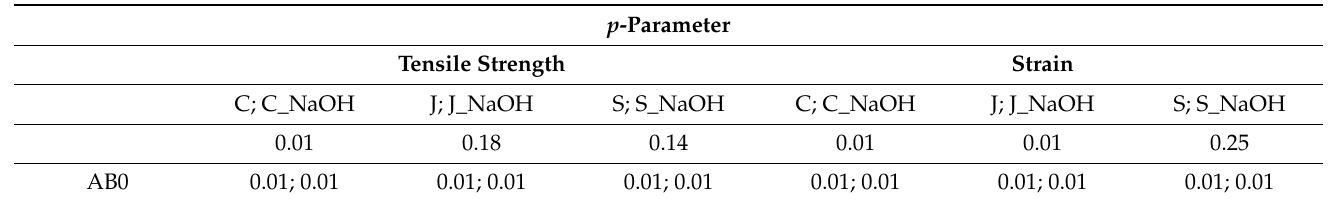
Table 4. Statistical evaluation of static tensile test at 0.05 level of significance-ANOVA F-test. p -Parameter